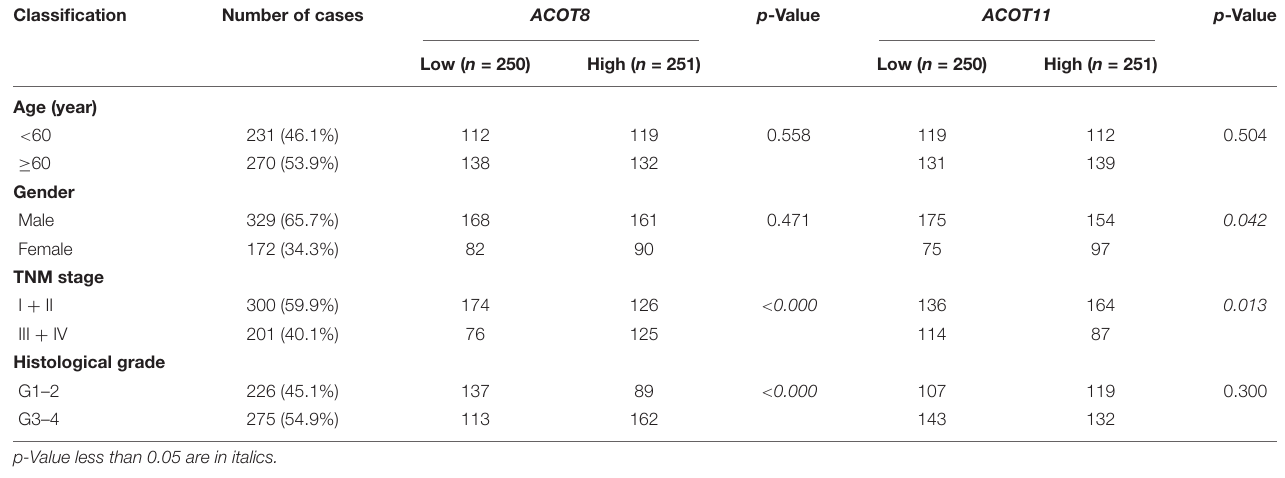
TABLE 1 | Association of different ACOTs with clinicopathologic characteristics in ccRCC patients.